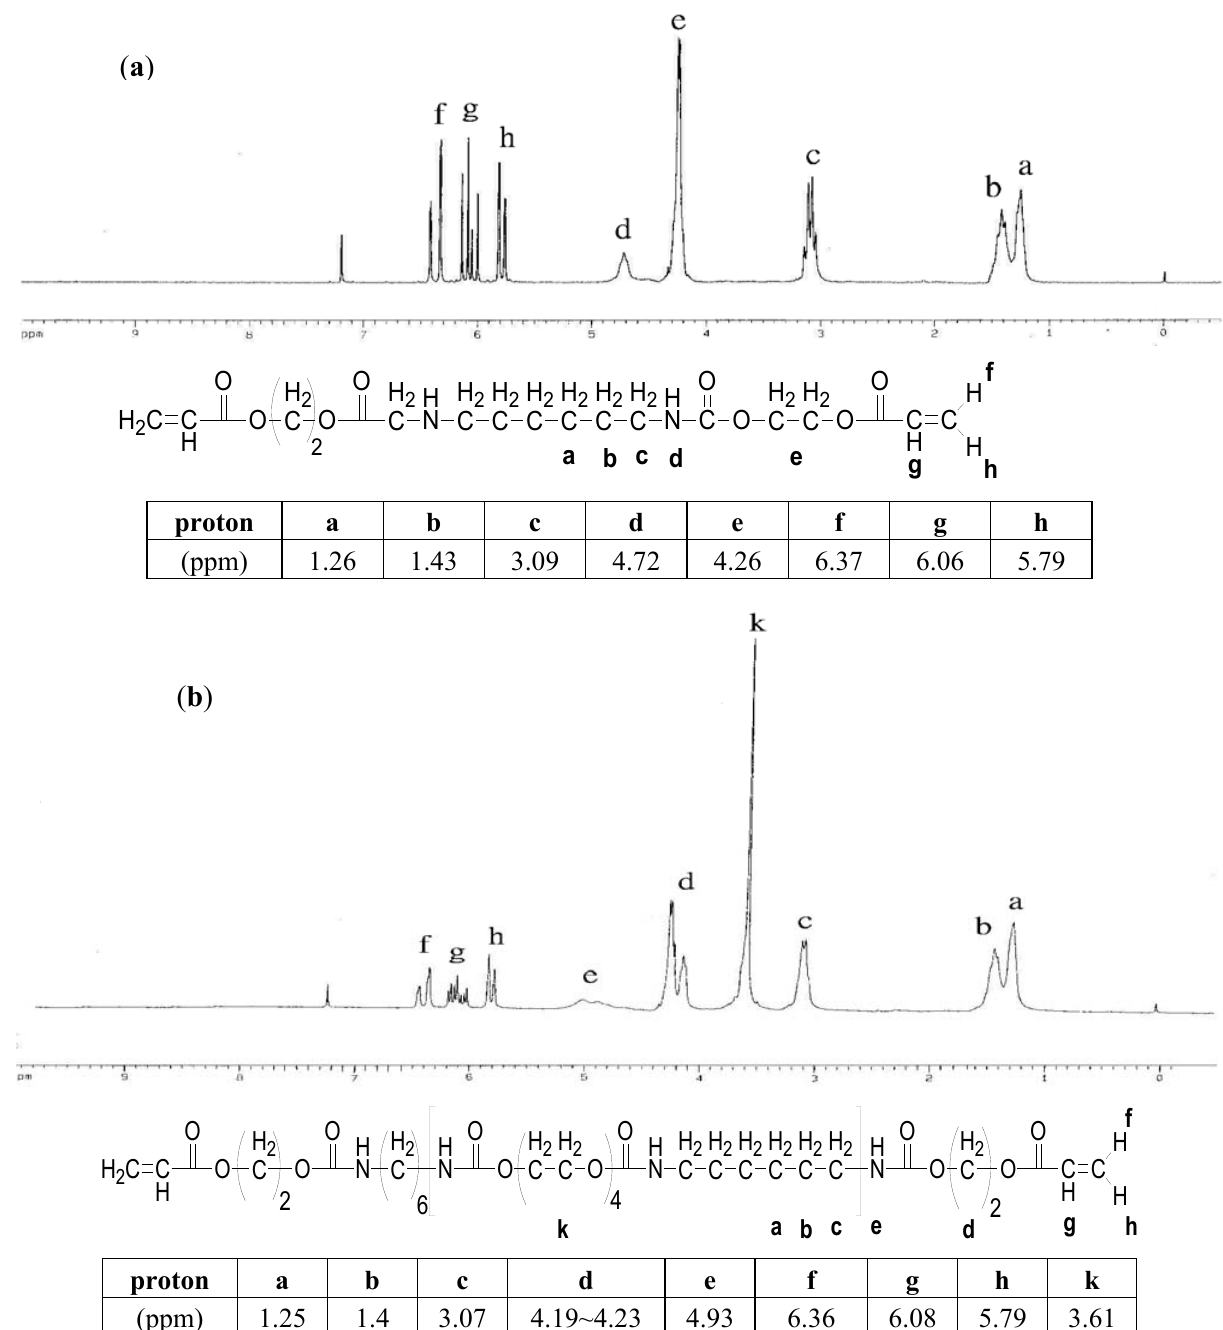
Figure 2. 1 H-NMR analysis of ( a ) UAA; ( b )